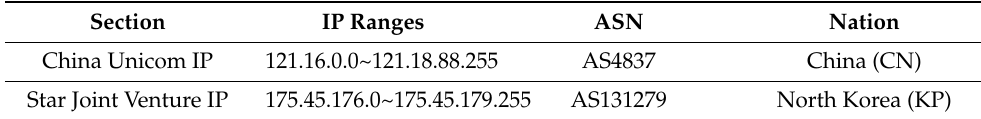
Table 7. List of hacking IP ranges in North Korea.